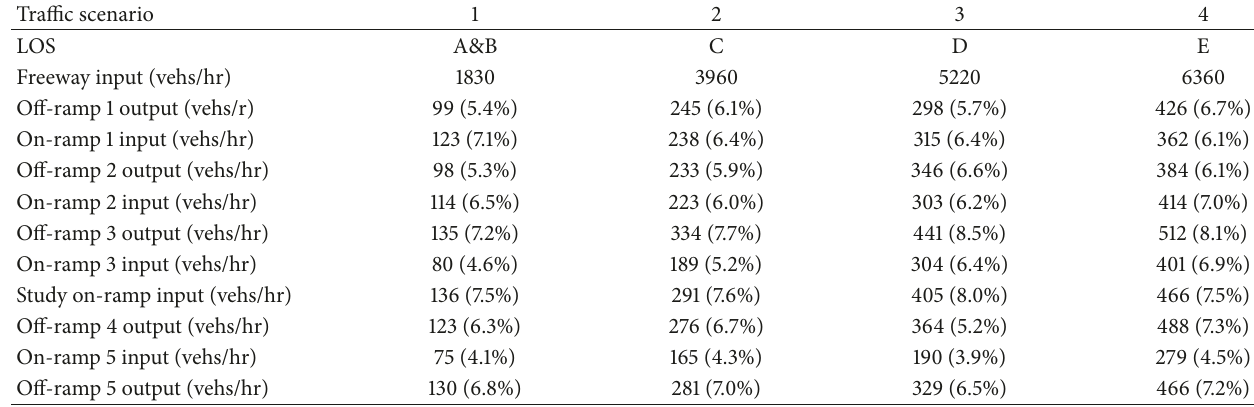
Table 3: The traffic flow configuration for each on-ramp and off-ramp.